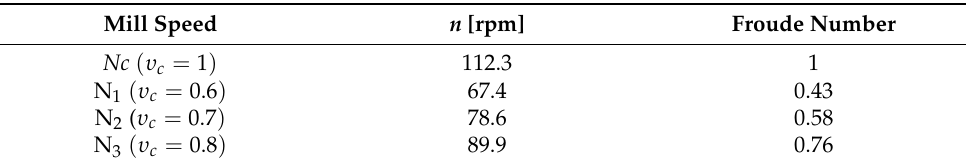
Table 1. Mill rotation speeds used in the grinding kinetic